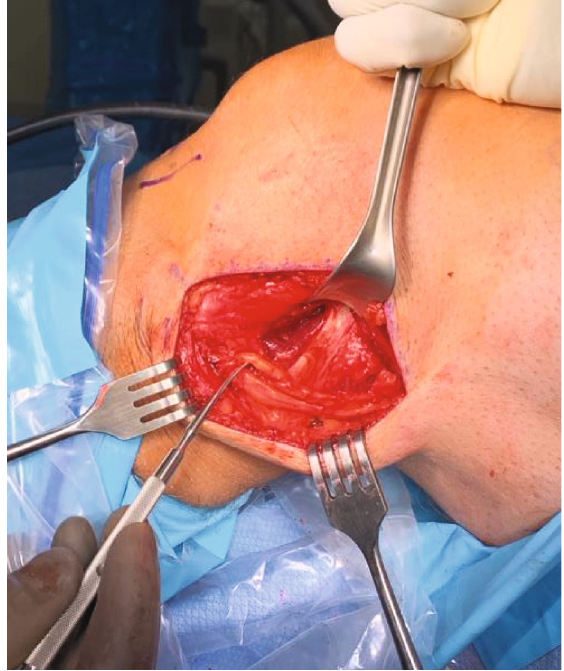
Figure 2: Bi fi d common peroneal